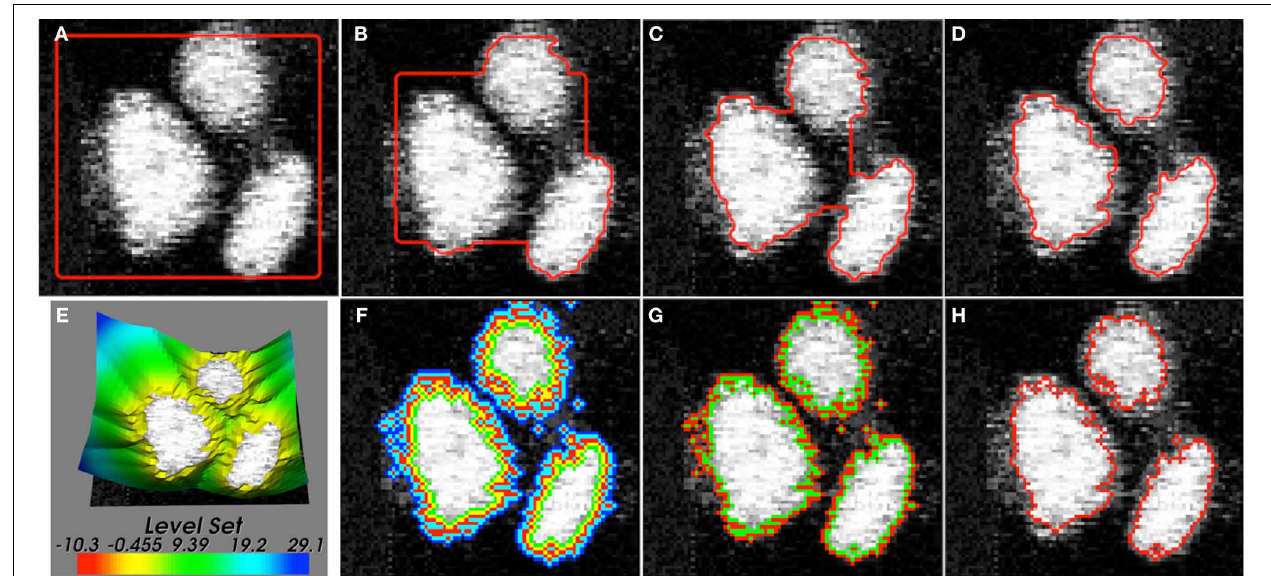
FIGURE 1 | (A–D) Iterative stages of active contour (red) evolution using level-sets for the segmentation of objects (cells in this case) in images. The underlying image is a 2D confocal microscopy section showing nuclei (H2B:GFP) in the zebrafish inner ear. (E) The level-set function is